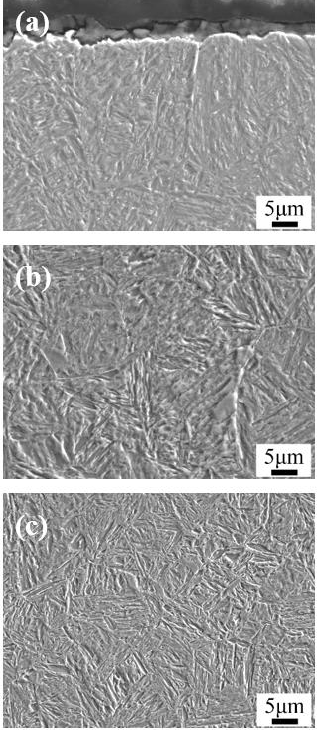
Figure 4. SEM images of the microstructures after carburizing and quenching: ( a ) the surface; ( b ) the subsurface; and ( c ) the core. Figures 5 and 6 are the optical micrographs and SEM images of the microstructure after low- temperature tempering, respectively. The matrix microstructure gradually transformed from high- carbon acicular martensite in the surface layer to low-carbon lath martensite in the core. No distinct carbide precipitation or change in the microstructure type was observed after quenching, and the substructure appeared slightly large.